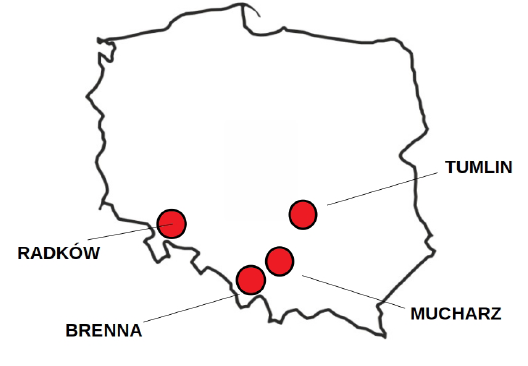
Figure 4: Location of the active quarries on the map of Poland from which the tested sandstones